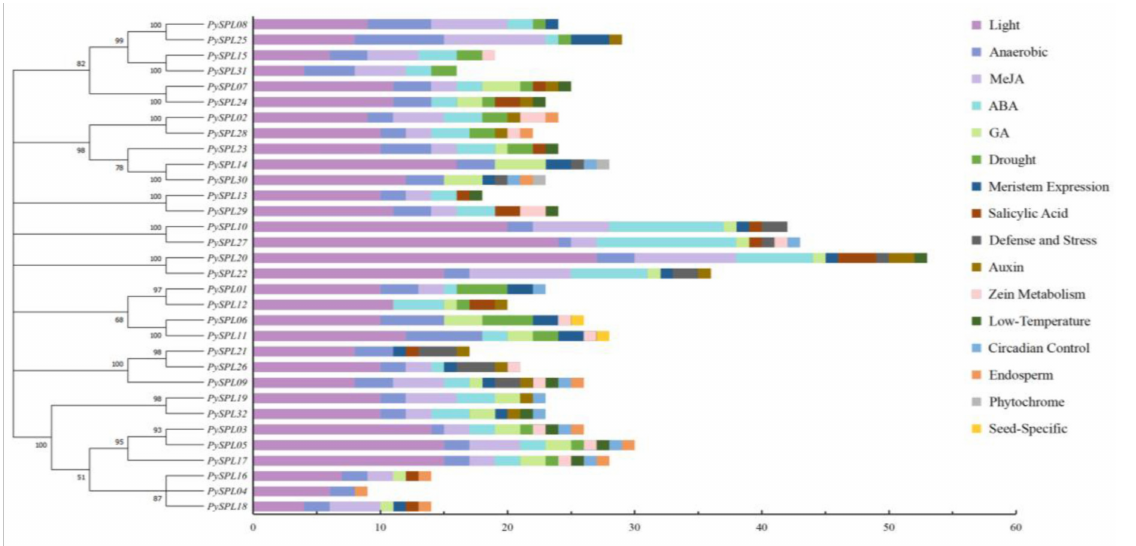
Figure 5. Cis -acting elements analysis of PySPLs promoters by Plantcare. Different colored boxes represent different cis -acting elements. The horizontal coordinate represents the number of cis -acting